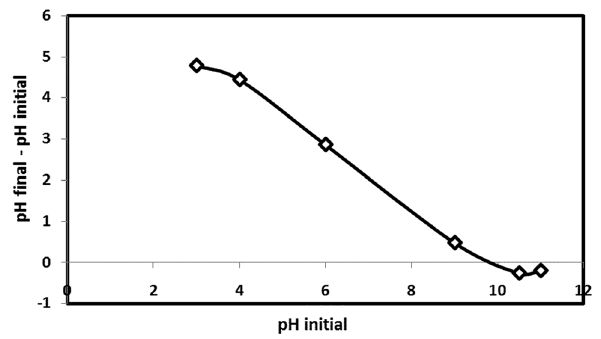
Fig. 4 Point of zero charge in clays Table 2 The BET surface area, total pore volume and average pore diameter for clay, HDTMA-clay and CPC-clay distanceAdsorbent S BET specific surface area, VP pore volume determined by BJH method from N 2 desorption isotherm, APD average pore diameter determined by the curve of BJH desorption d V /d D pore volume, d 001 Basal